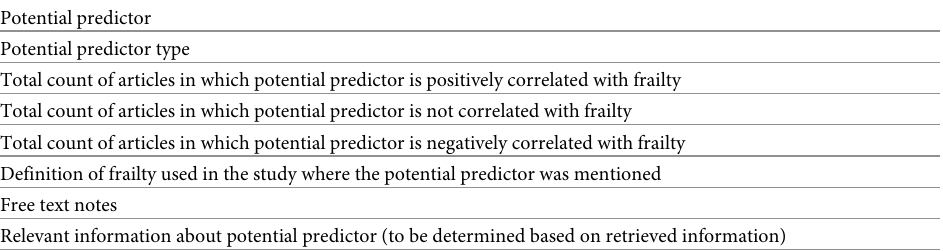
Table 1. Format for collecting extracted potential predictors for